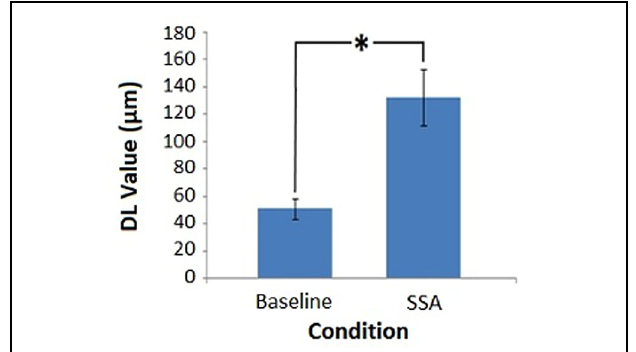
FIGURE 4 | Pre-tDCS amplitude discrimination thresholds. Average DL values for each task condition, obtained prior to DC stimulation ( ∗ denotes significance, p < 0.05). Error bars represent ± 1